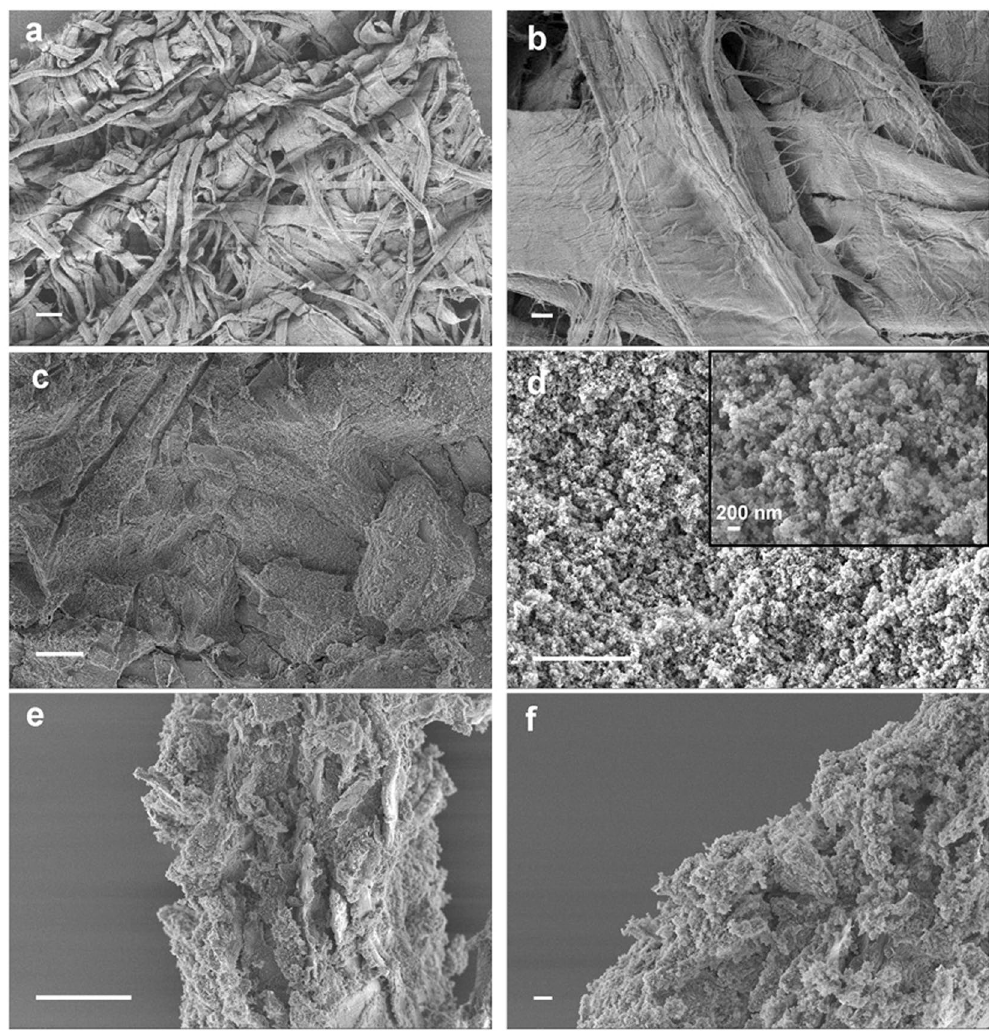
Figure 2. SEM images of the overview and close view of ( a , b ) native tissue paper, ( c , d ) the front view of porous membrane PPHM-3, and ( e , f ) the cross-section of PPHM-3. The scale bar is 50 µ m in ( a , c , and e ) and 5 µ m in ( b , d and f ). The inset is an enlarged view of ( d ).